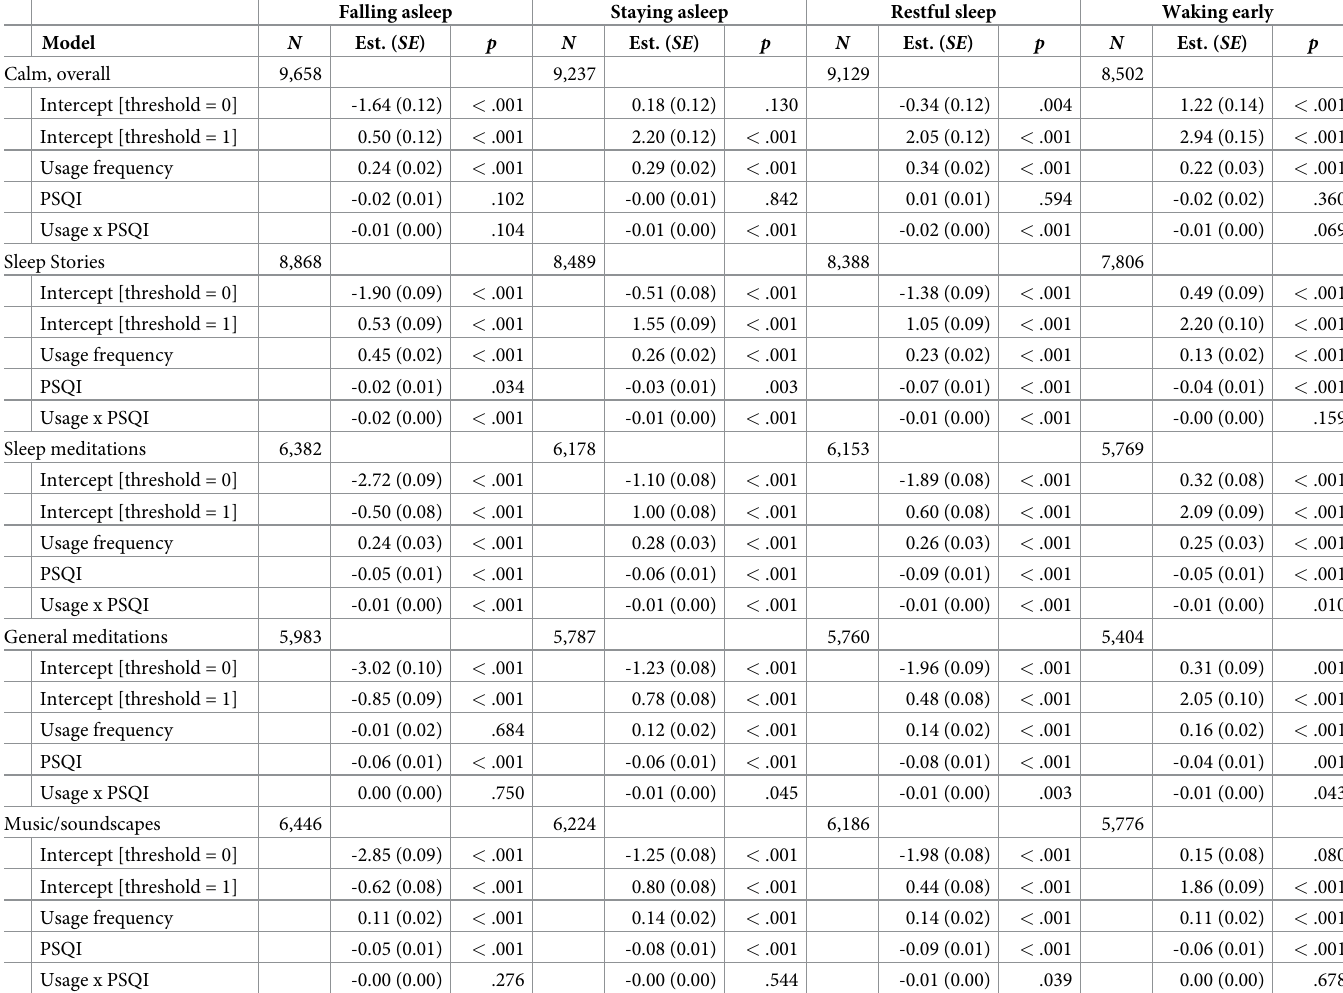
Table 6. Parameter estimates for regressions models of improvements in sleep disturbance based on frequency of using Calm and its components, PSQI scores, and the interaction between frequency of use and PSQI (i.e., Step 2). Falling asleep Staying asleep Restful sleep Waking